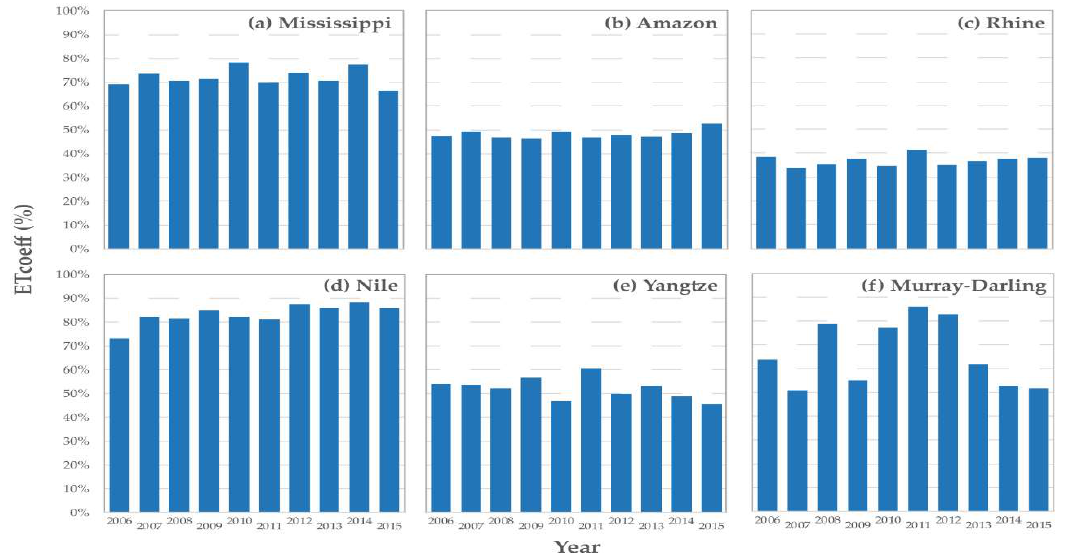
Figure 6. Yearly ETcoeff (ETa/PPT) variability for six major river basins over 10 years